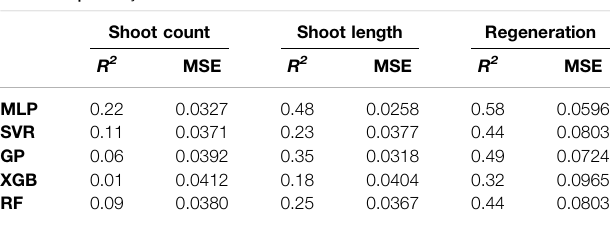
TABLE 3 | Validity of the models. Shoot count Shoot length